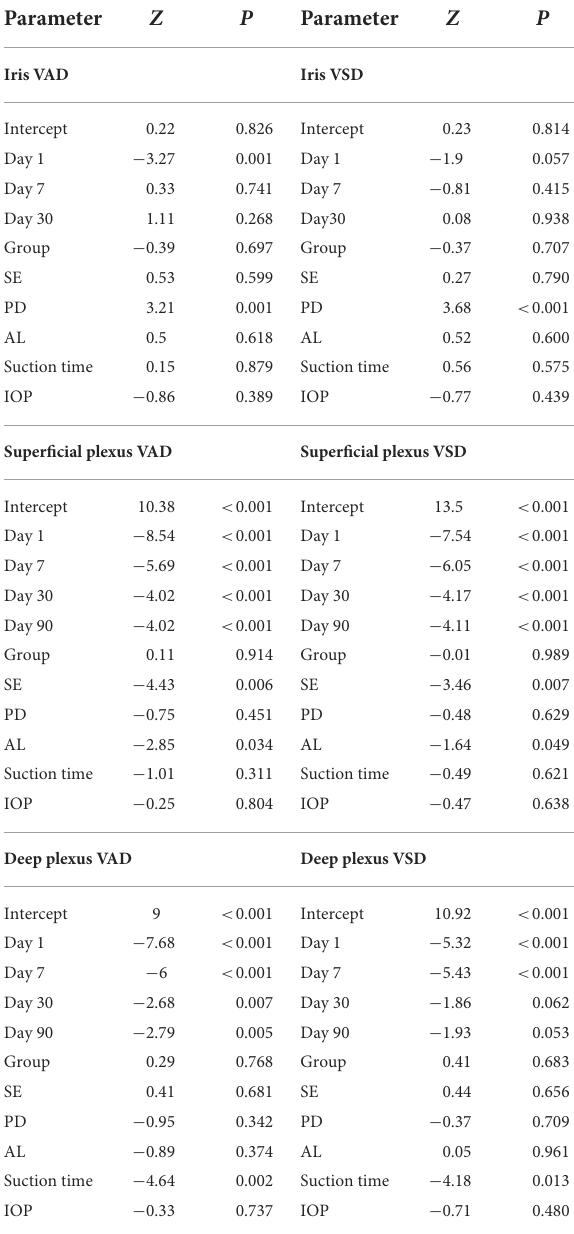
TABLE 4 Analyses of the repeated measured iris and retinal blood flow indices and the relationship with other